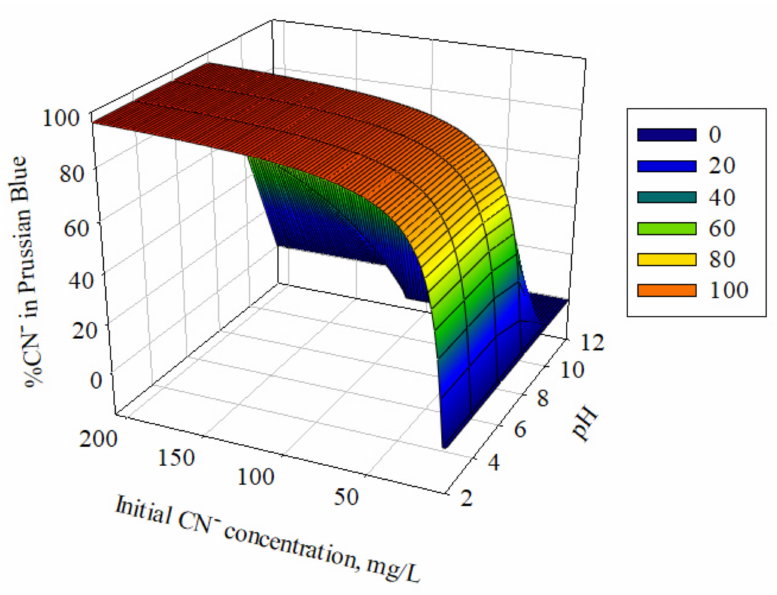
Figure 3. Percentage of CN − in PB and concentration of residual CN − as function of initial CN − concentration and pH at Fe:CN − molar ratio of 0.5 by MINEQL+. Fixed DO of 5.0 mg O 2 /L. Temperature of 25 ◦